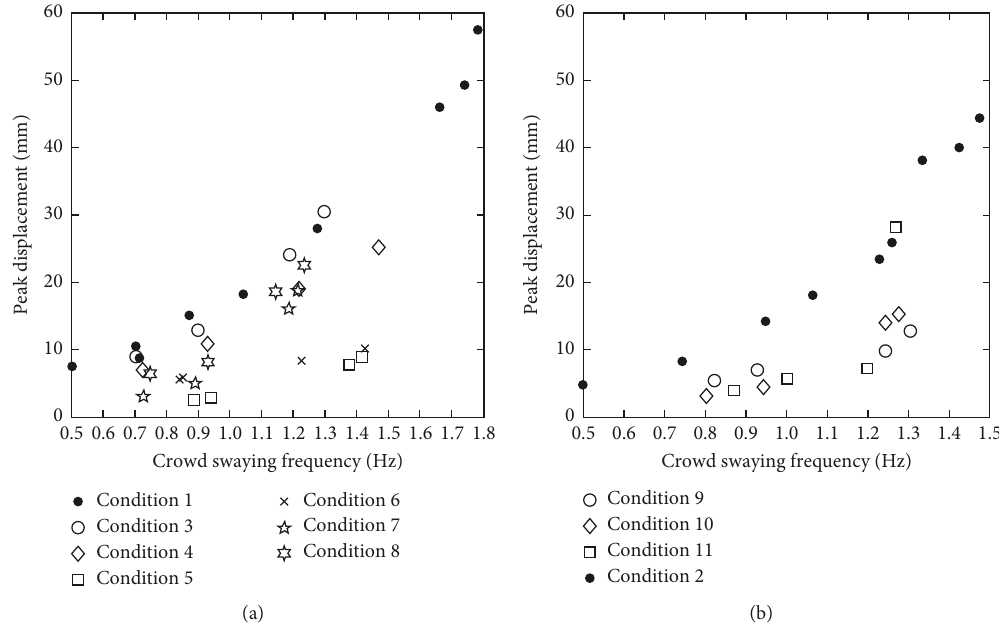
Figure 14: The maximum structural displacements at different crowds swaying. (a) Standing crowd. (b) Seated